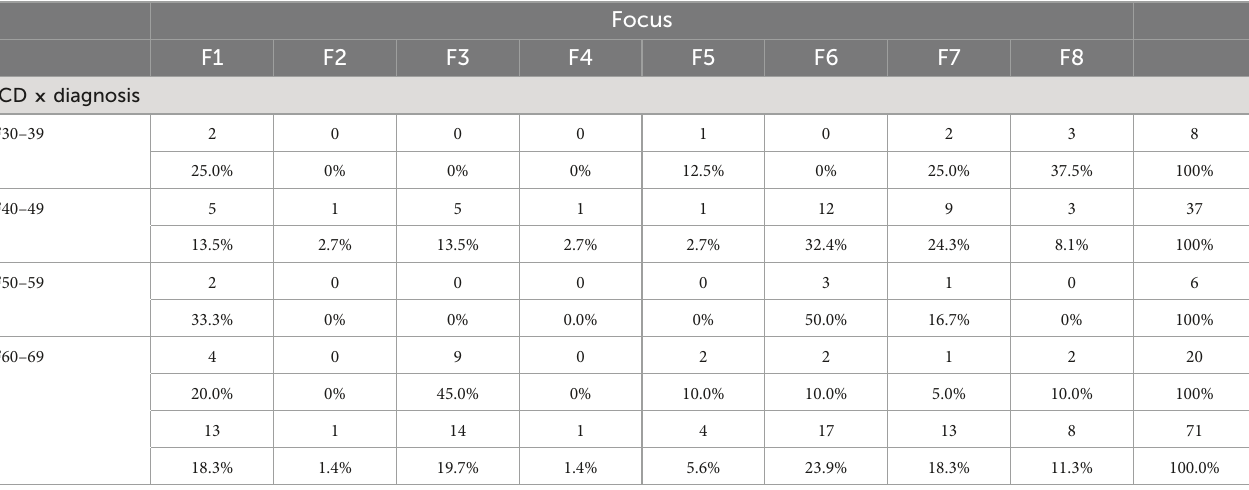
TABLE 2 Focus distribution according to ICD